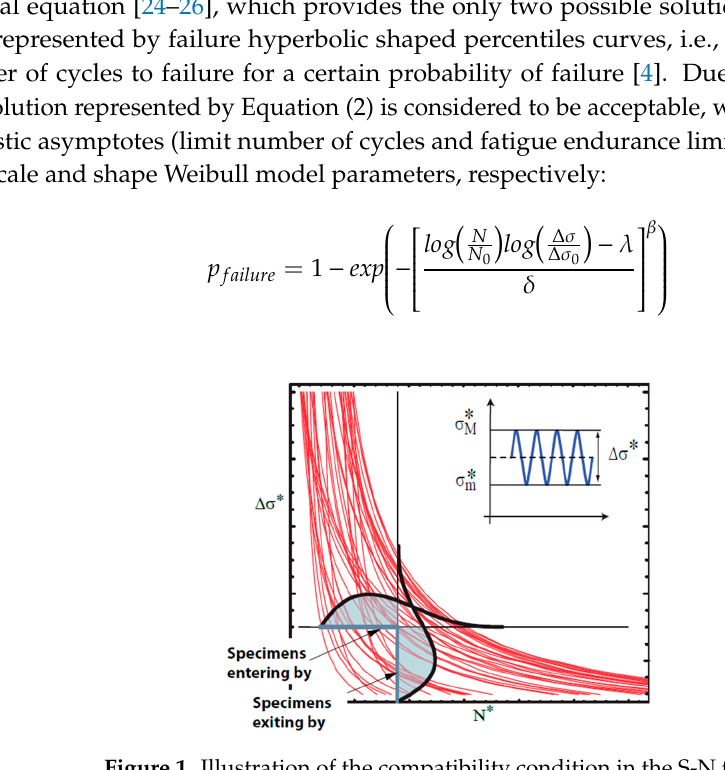
Figure 1. Illustration of the compatibility condition in the S-N field.